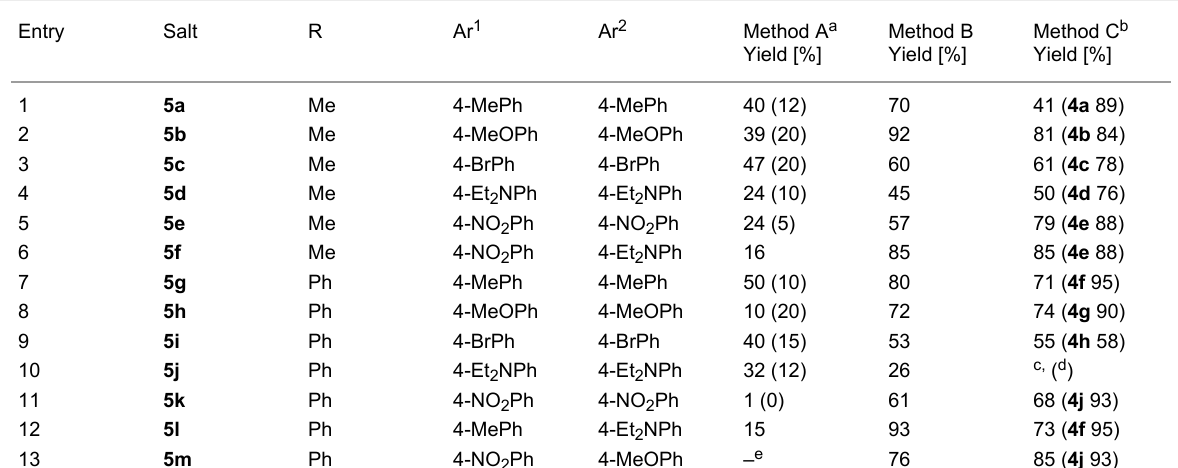
Table 1: Comparison of the individual methods for the synthesis of the salts 5